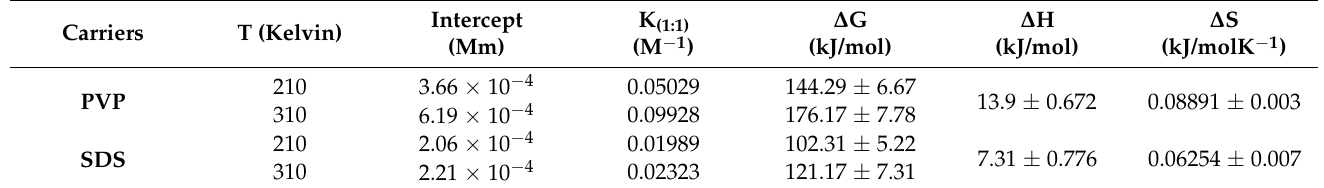
Table 1. Thermodynamic parameters of CRL with PVP and SDS s at 25 and 37 ◦ C (mean ± SD, n = 3). Carriers T (Kelvin)